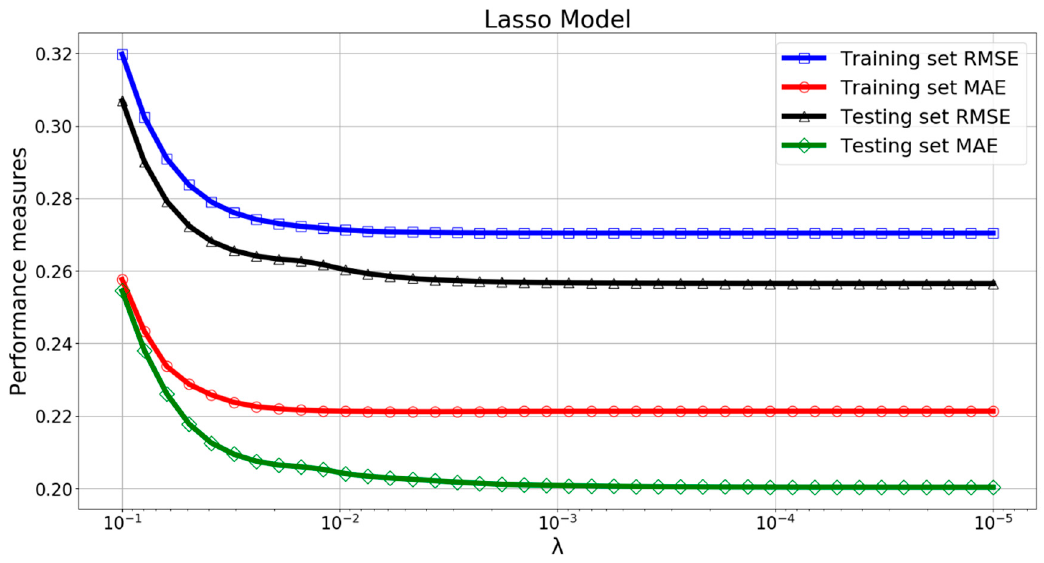
Figure 12. RMSE and MAE versus parameter λ for the Lasso model.